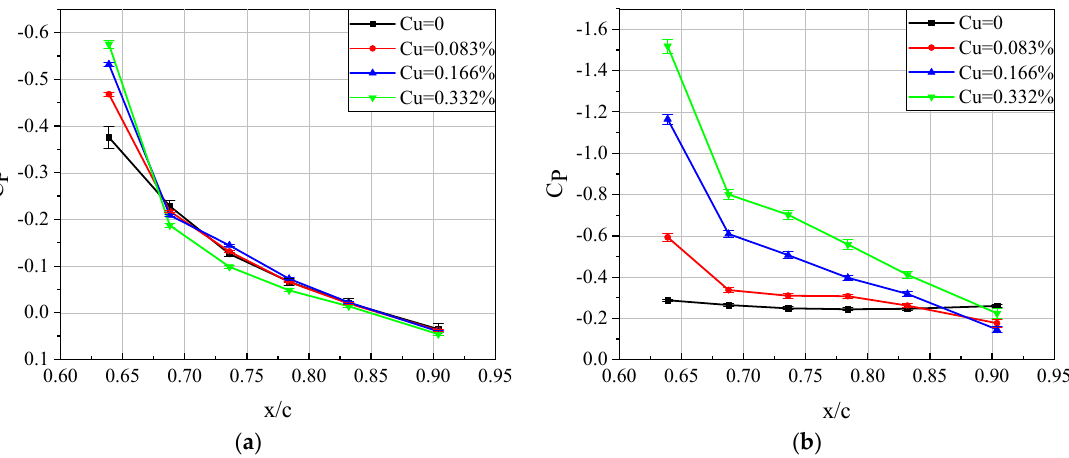
Figure 13. Rudder pressure distribution under different momentum coefficient controls: ( a ) δ = 5°; ( b ) δ = 25° ( β = 0°, Re = 2.12 × 10 5 ).